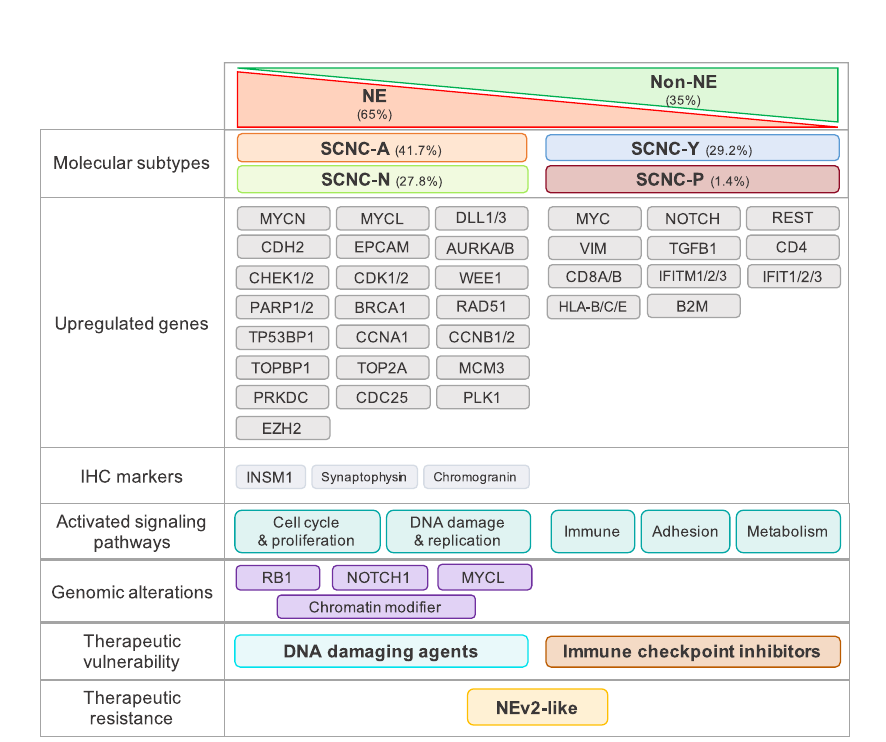
Fig. 7 Summary of molecular characteristics and potential therapeutic vulnerabilities in NE and non-NE SCNC. Subtype-speci fi c upregulated genes, IHC markers, signaling pathways, genomic alterations, therapeutic vulnerability, and resistance are